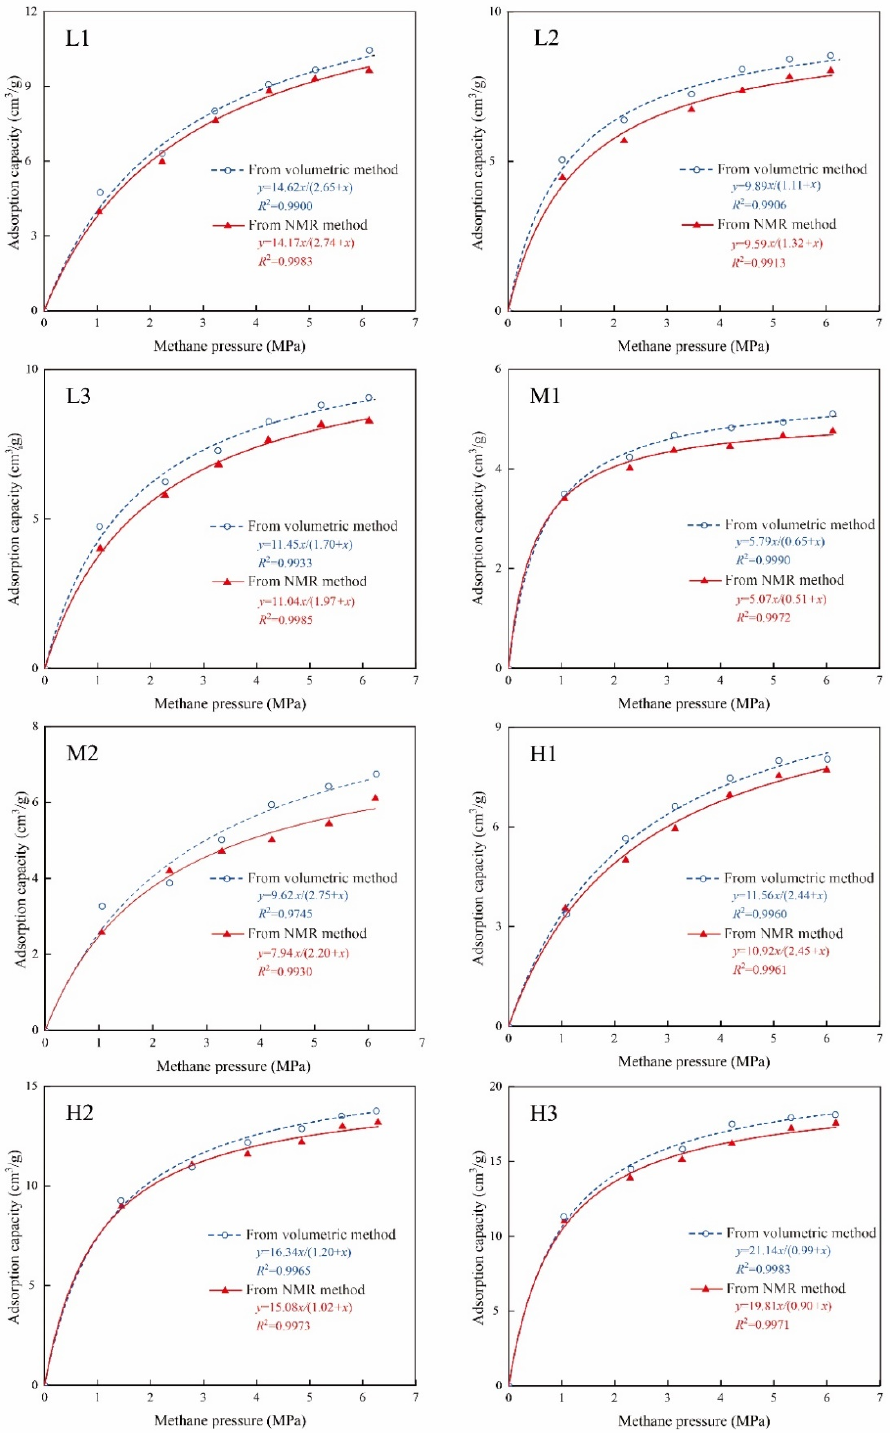
Figure 7. Adsorption isotherms obtained from two different methods.